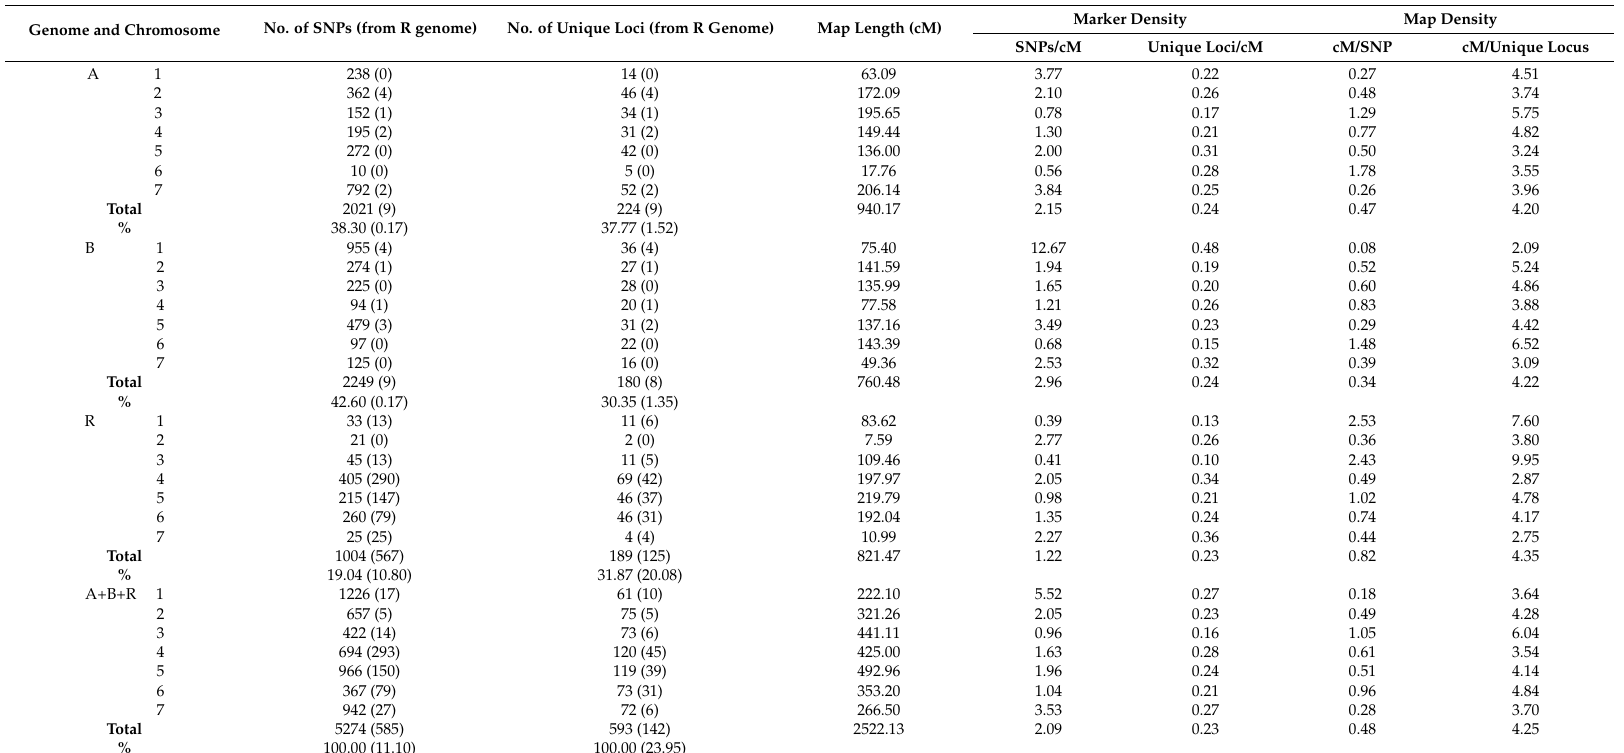
Table 3. Details of number of mapped SNPs, map length and SNPs densities of individual chromosomes, seven homoeologous groups and three genomes (A, B and R genomes). Genome and